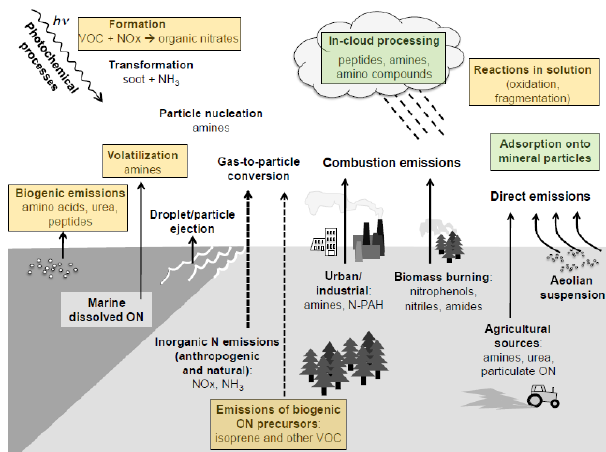
Figure 8. Processes where increased temperatures would be ex- pected to increase atmospheric ON (orange) or decrease ON (green); no colour code implies uncertain effects. Adapted from Jickells et al.